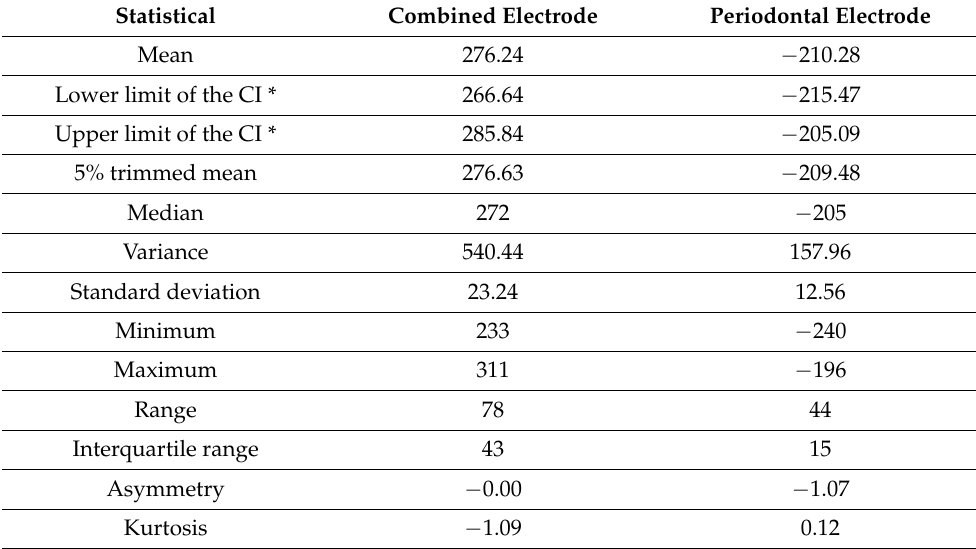
Table 2. Descriptive analysis of the electrodes. Results in mV.